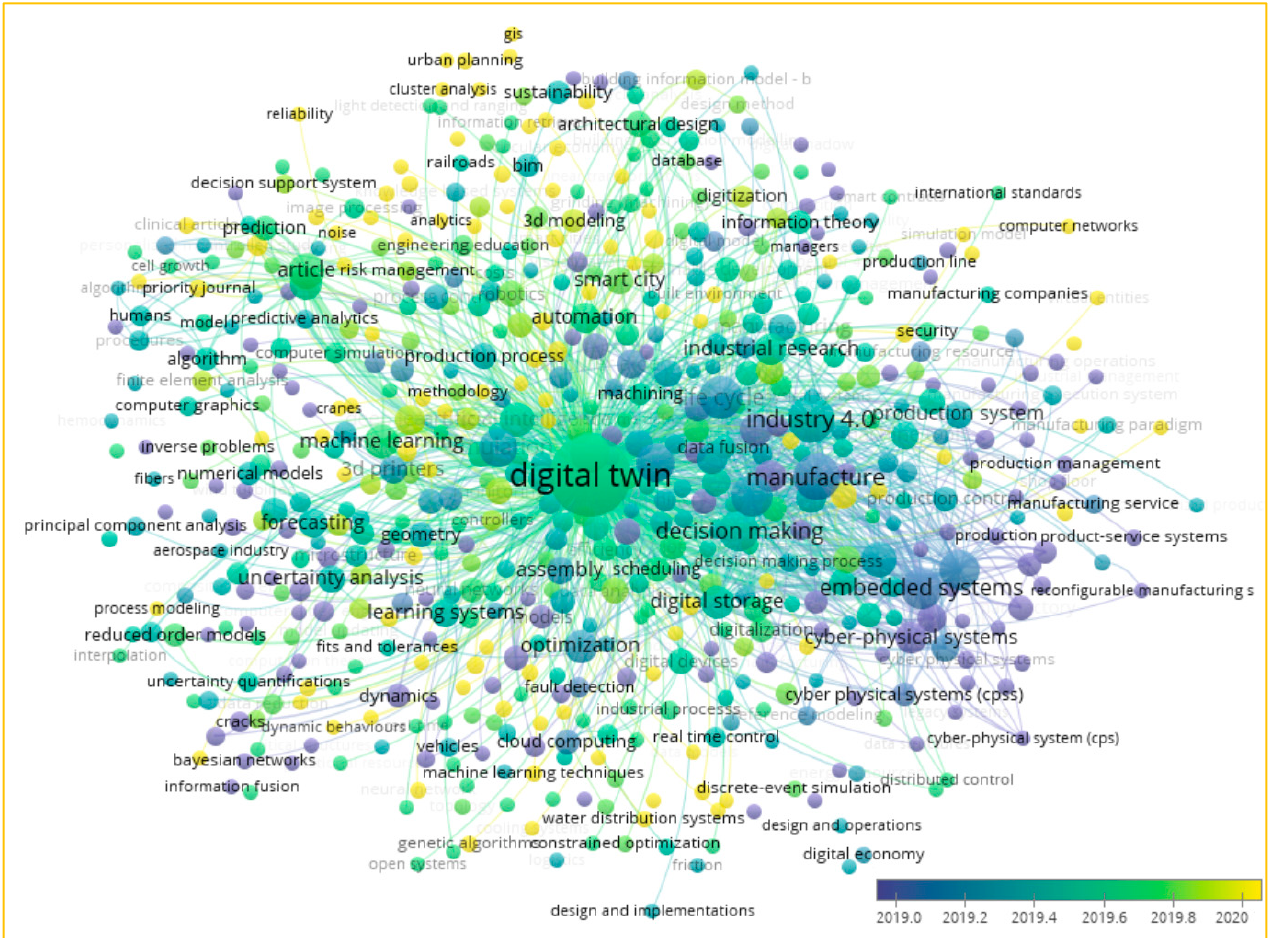
Figure 3. Co-occurrence of keywords in the literature with a minimum of 635 words out of 6877 from the data set of 817 documents published in the past decade (2011 to December 2020).